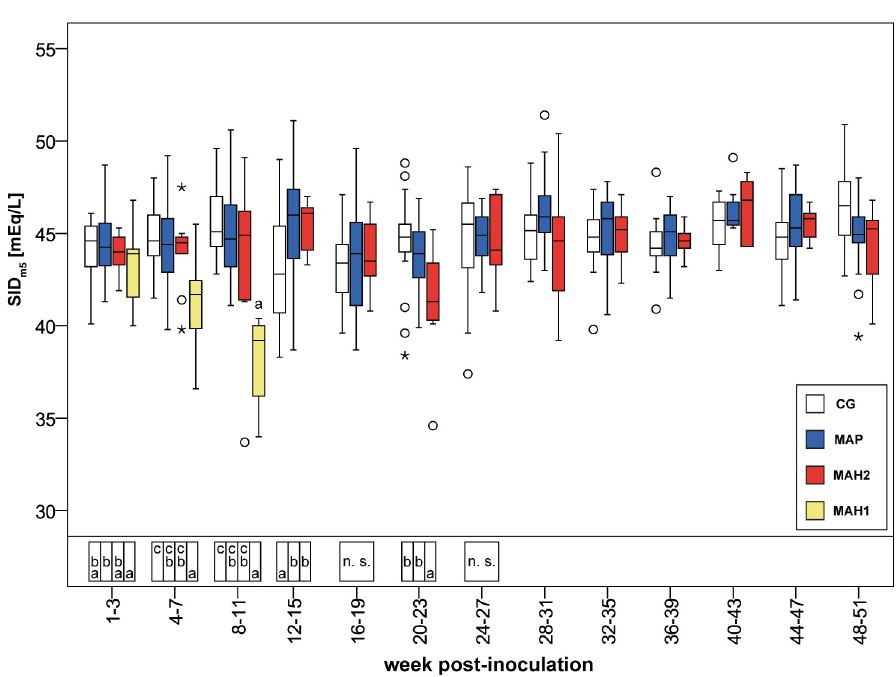
Fig 5. Calculated strong ion difference based on 5 measured strong ions assessed in venous blood. CG, control group. MAP, group infected with Mycobacterium avium subsp. paratuberculosis . MAH 1, sub-group infected with Mycobacterium avium subsp. hominissuis with acute, severe form of infection. MAH 2, sub-group with chronic form of infection. Different letters indicate significant differences between groups within one period (Mann-Whitney U -test, P < 0.05). n.s., no significant differences between groups in the given period. From 28 th week onwards Mann-Whitney U -test was not performed due to reduced numbers of observations. Significant differences within groups (Friedman test, P < 0.05) from 1 st -3 rd to 24 th -27 th wpi are given in S3–S5, and S10 Tables.